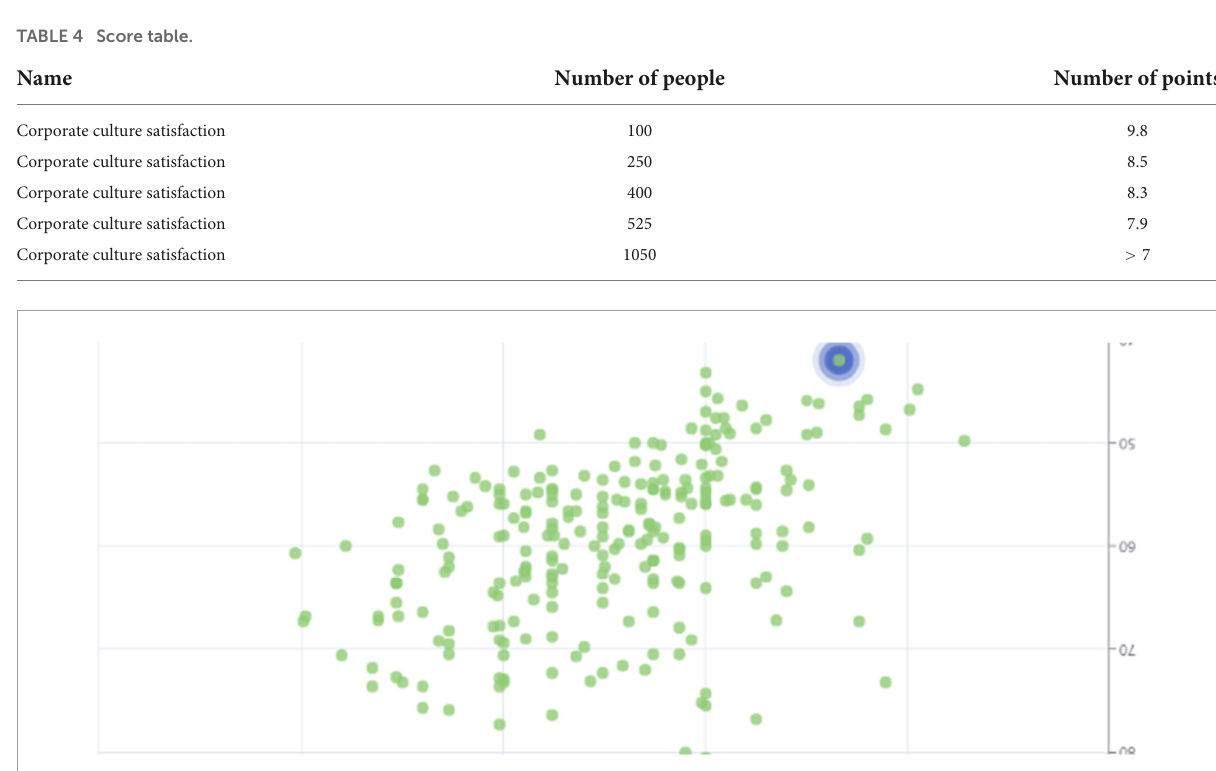
FIGURE2 Distribution of affective values.